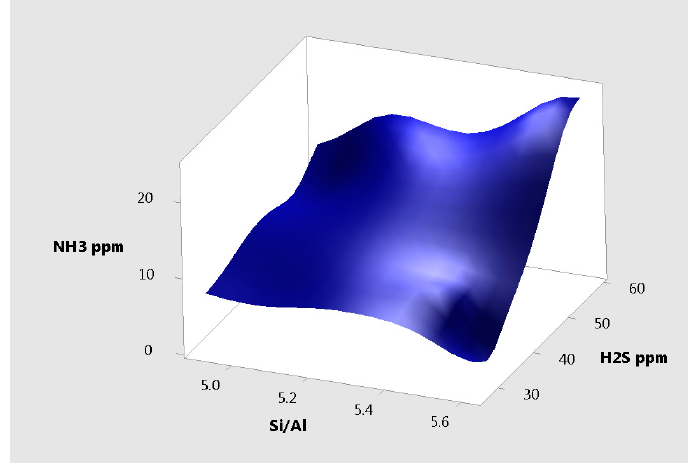
Figure 11. Surface plot of NH 3 vs. Si/Al, H 2 S.